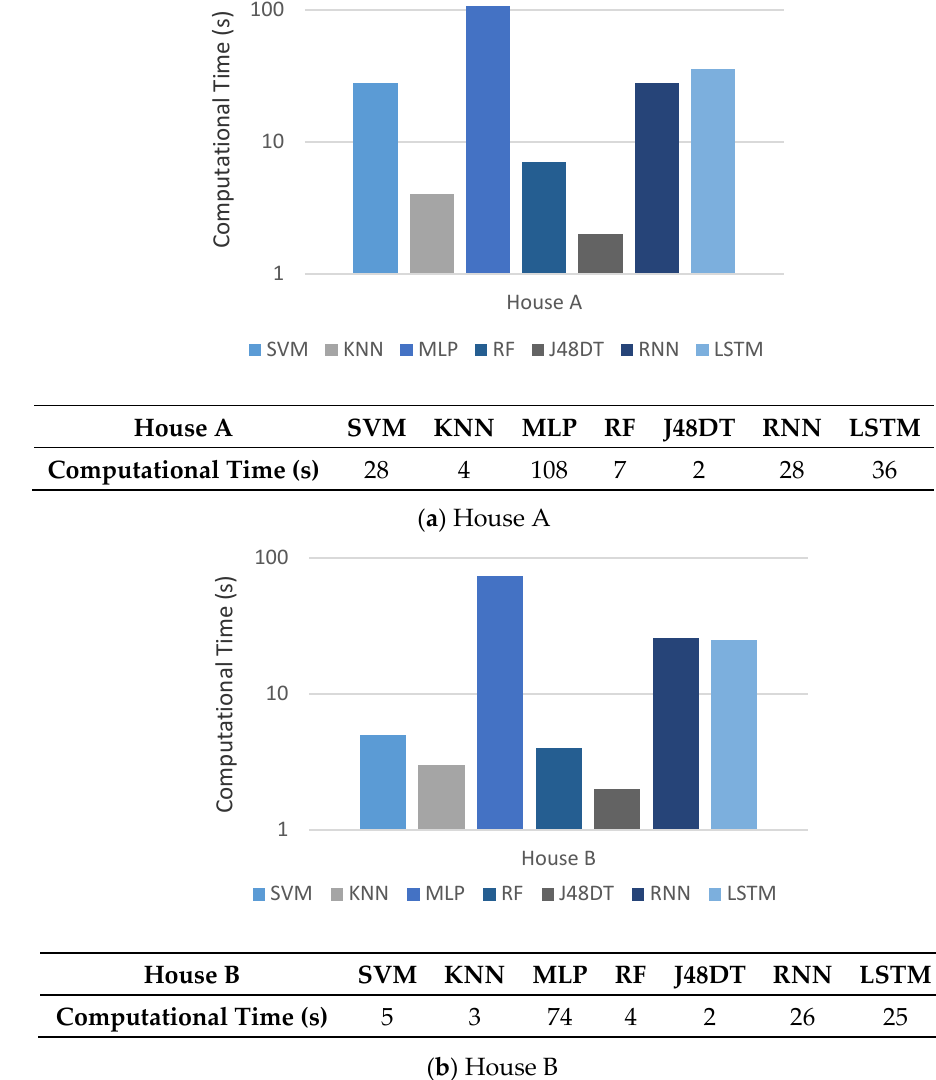
Figure 11. Convergence graph of RNN and LSTM.